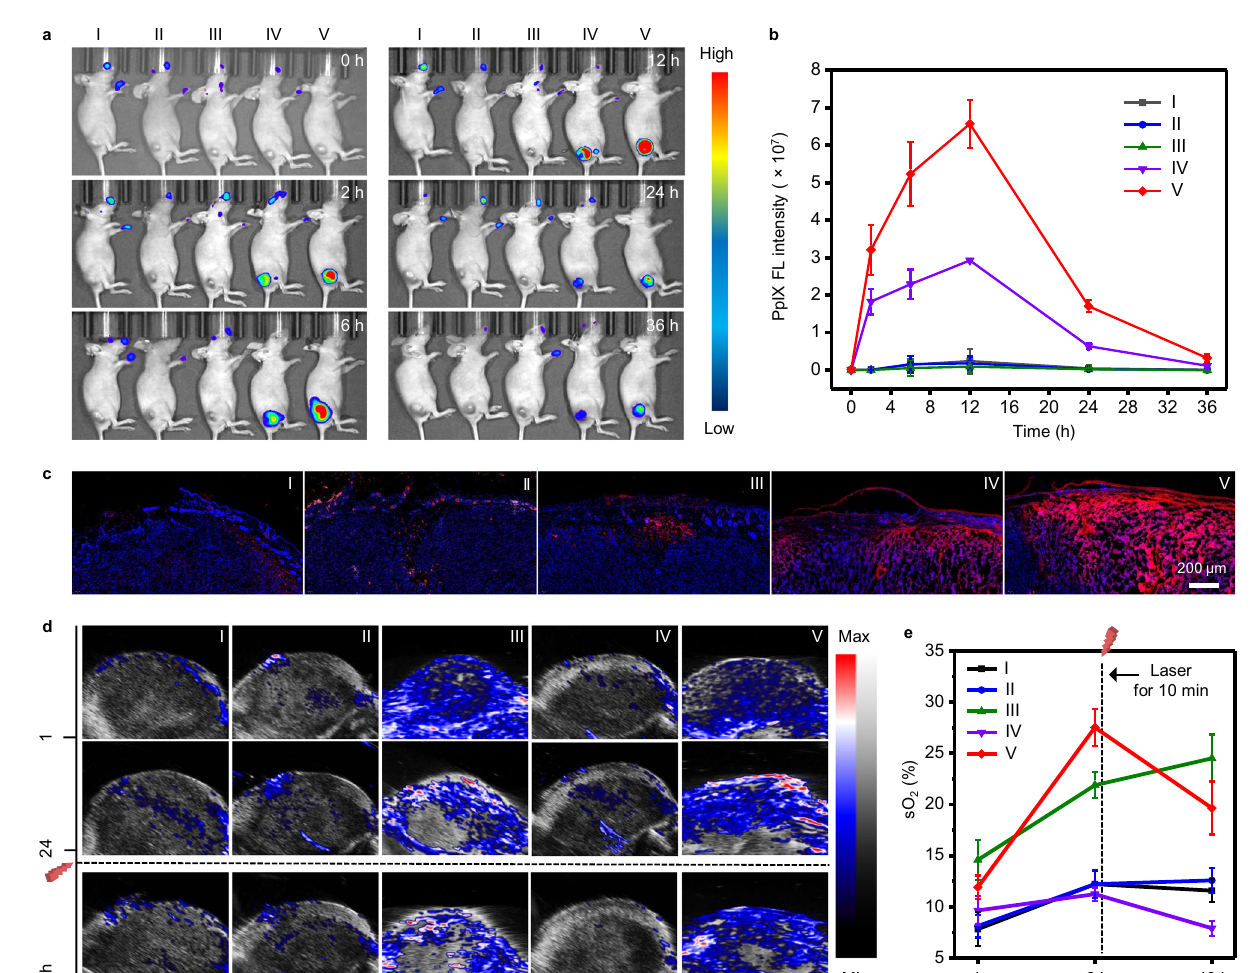
Fig. 5 | In vivo real-time quantitative analysis of PpIX metabolism and sO 2 levels by FL/PA duplex imaging. a In vivo PpIX FL images of A375 tumor-bearing mice visualized using anIVISspectrum system afterviaious treatments (I: Control; II: MN-CCP; III: MN-CCPC; IV: MN-CCPA; V: MN-CCPCA). b The FL intensity of the tumor site after administration of MN patches at the indicated time points. Data representthemeans±SDfromthreebiologicallyindependentfemaleA375tumor- bearing mice, n =3. c Biodistributions of different MN patch-derived PpIX in skin and tumor were monitored by FL cross sections (red from PpIX and blue from